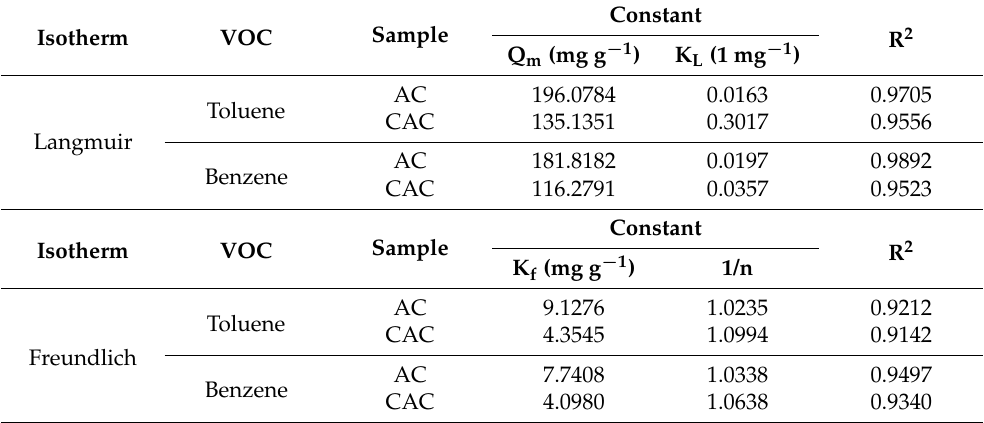
Table 4. Langmuir and Freundlich constants of samples by various concentrations of toluene and